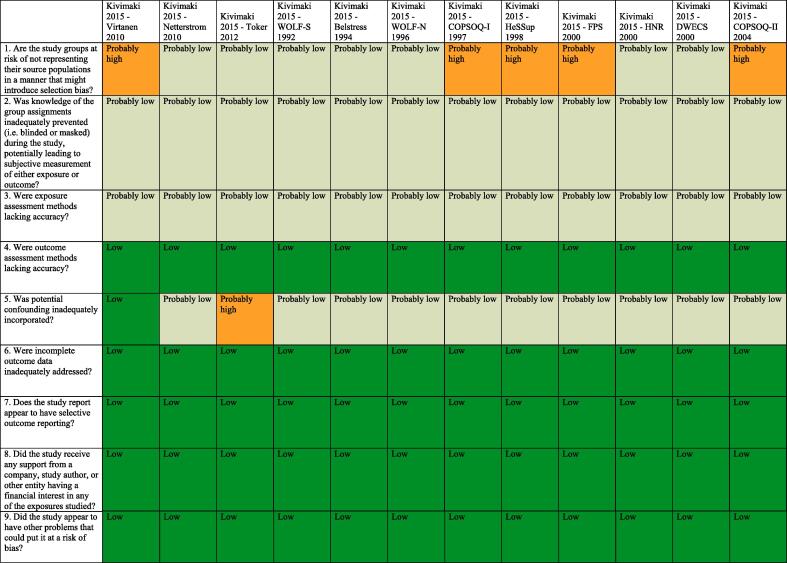
Summary of risk of bias, Acquired ischaemic heart disease (IHD incidence). Footnotes: * Case-control study (supporting evidence).